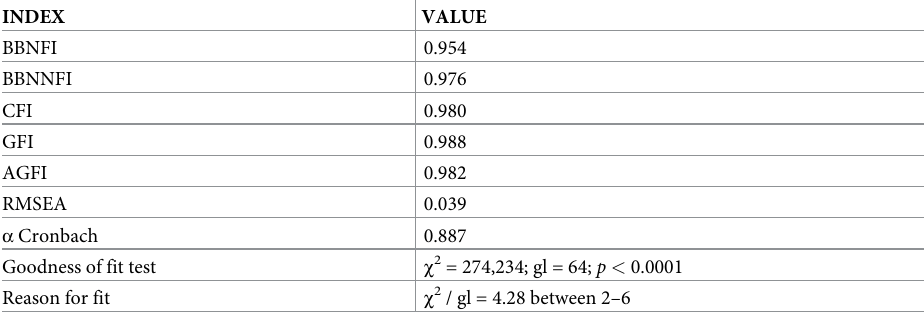
Table 4. Indices of goodness of fit of the confirmatory model.